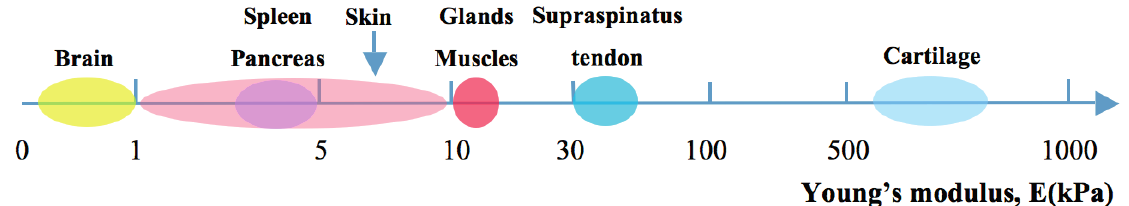
Figure 1. Young’s modulus of natural soft tissues and organs in